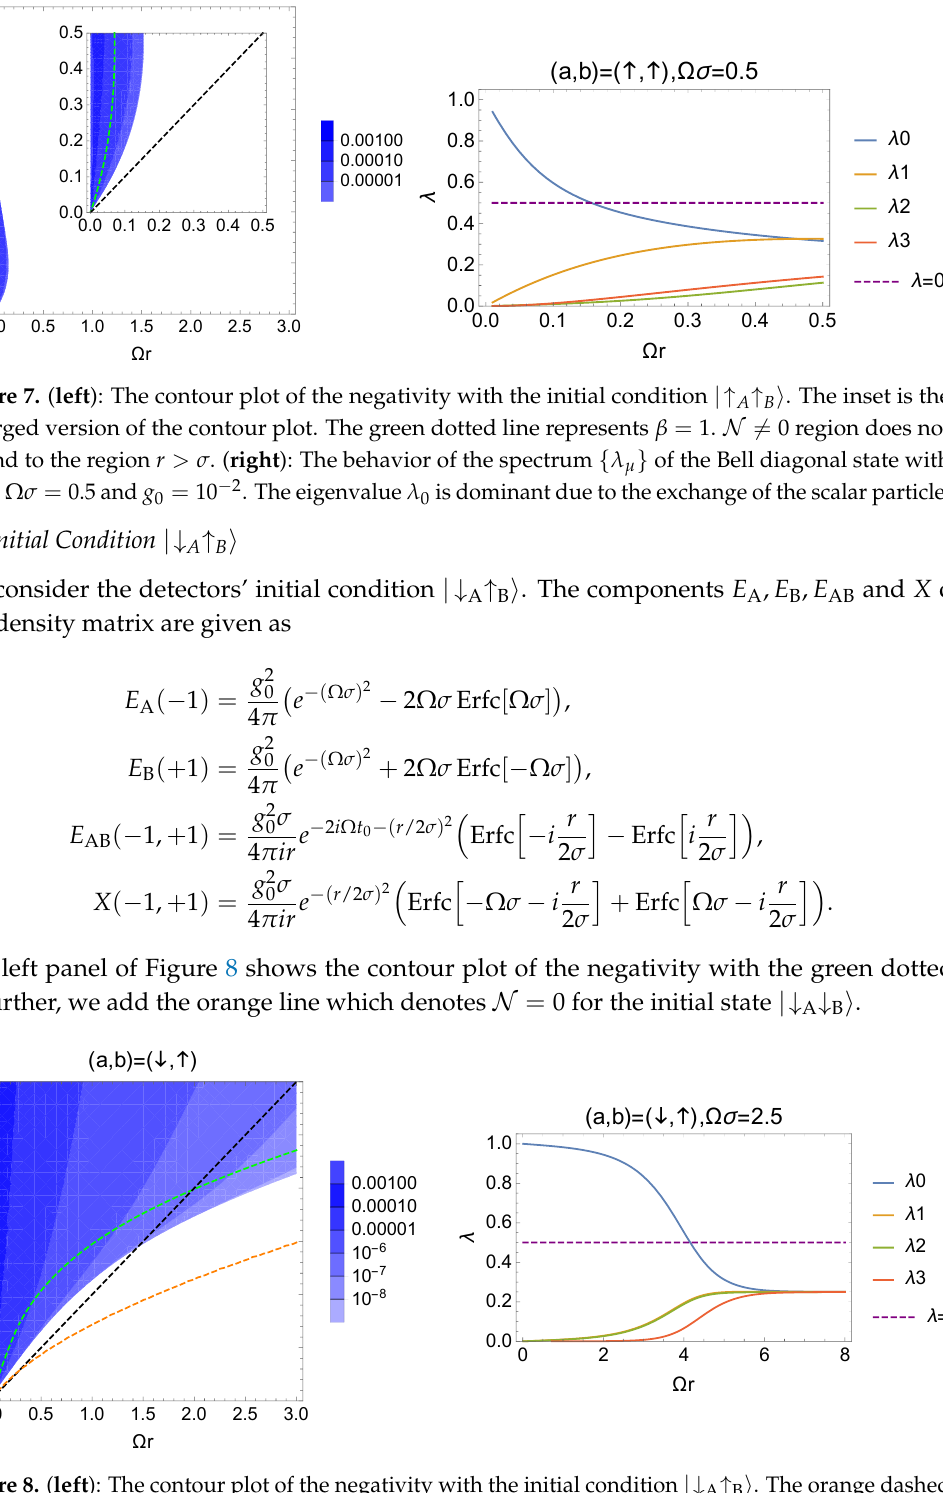
Figure 8. ( left ): The contour plot of the negativity with the initial condition |↓ A ↑ B (cid:105) . The orange dashed line denotes the boundary of the nonzero negativity with the initial state |↓ A ↓ B (cid:105) . In this case, the size of the parameter region which shows the quantum correlations is smaller compared to the case |↓ A ↓ B (cid:105) . ( right ): The behavior of the spectrum { λ µ } as a function of Ω r with fixed Ω σ = 0.5 and g 0 = 10 − 2 . We observe that the region with the nonzero negativity is smaller compared to that for the initial state |↓ A ↓ B (cid:105) but larger than that for the initial state |↑ A ↑ B (cid:105) . This is because the probability